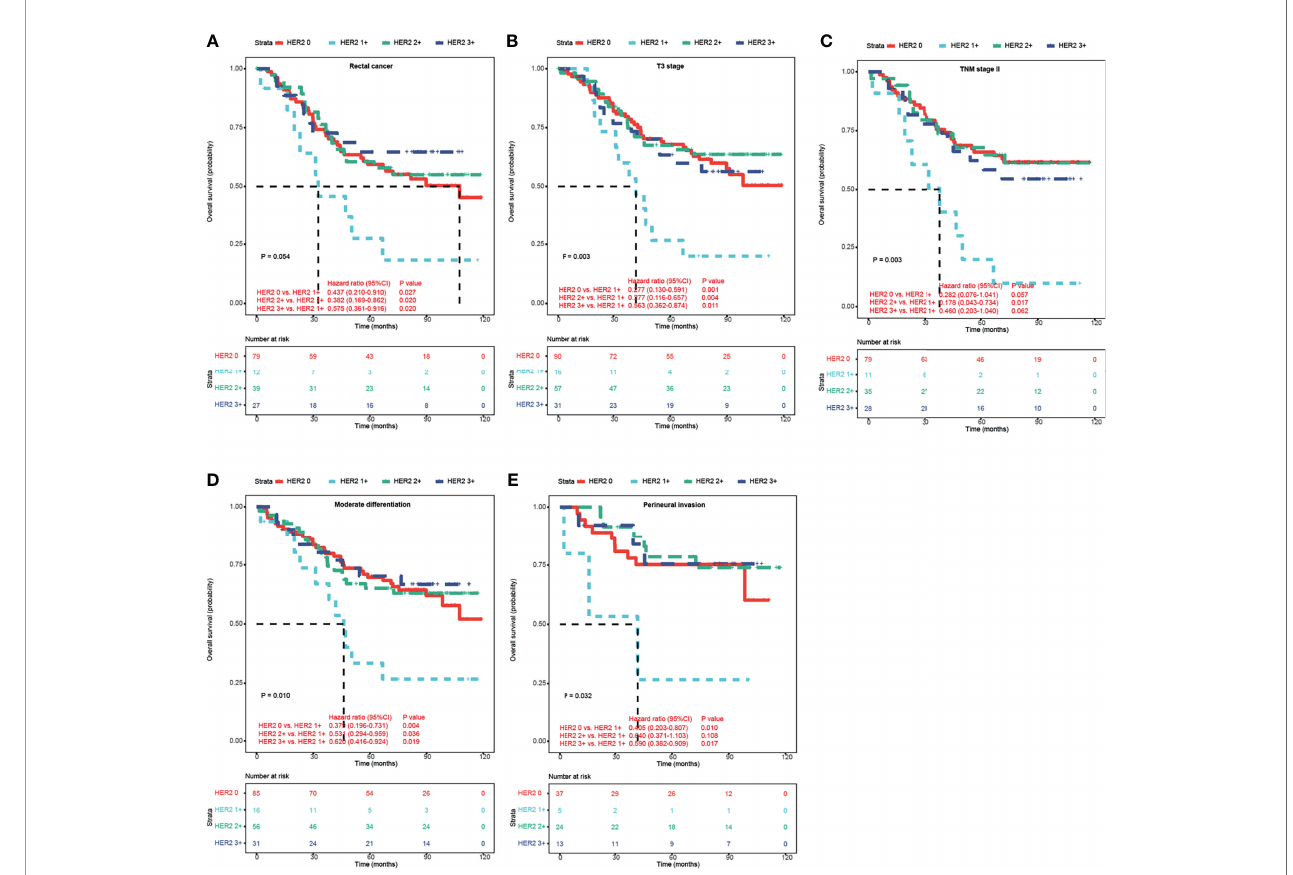
FIGURE 3 | Kaplan – Meier survival analyses of HER2 expression in CRC patients according to HERACLES criteria. Kaplan – Meier OS analysis of patients with rectal cancer (A) , T3 stage (B) , TNM stage II (C) , moderate differentiation (D) , and perineural invasion (E) based on HER2 expression status. HER2, human epidermal growth factor receptor 2; CRC, colorectal